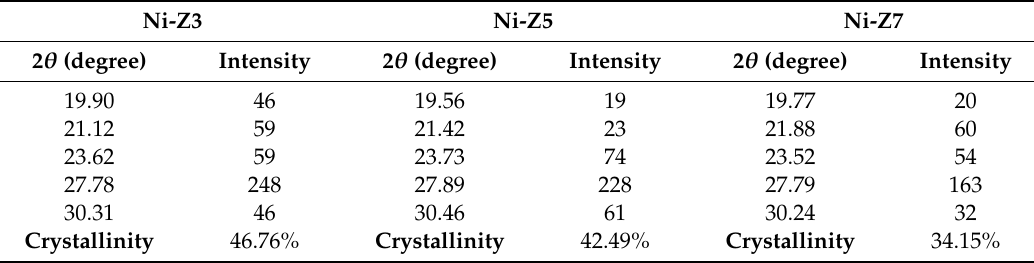
Table 6. 2 θ (degree) peak intensity comparison of Ni-Z3, Ni-Z5, and Ni-Z7 di ff